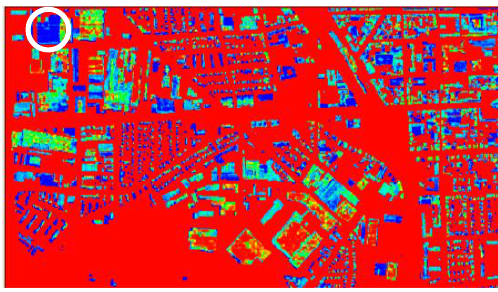
Figure 3: Classification probability map.